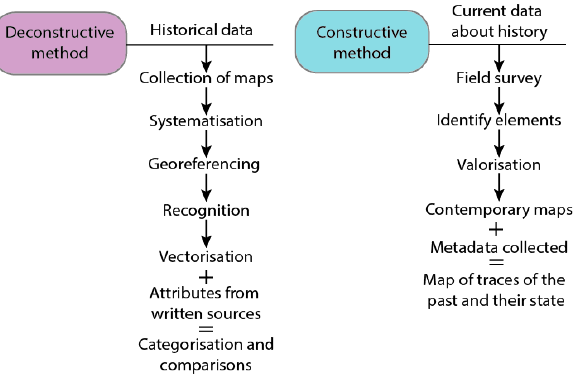
Figure 2. Structure of Constructive and Deconstructive